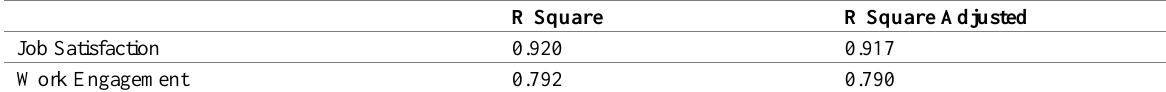
Table 5: Results of Determinant Coefficient Test (R-Square)